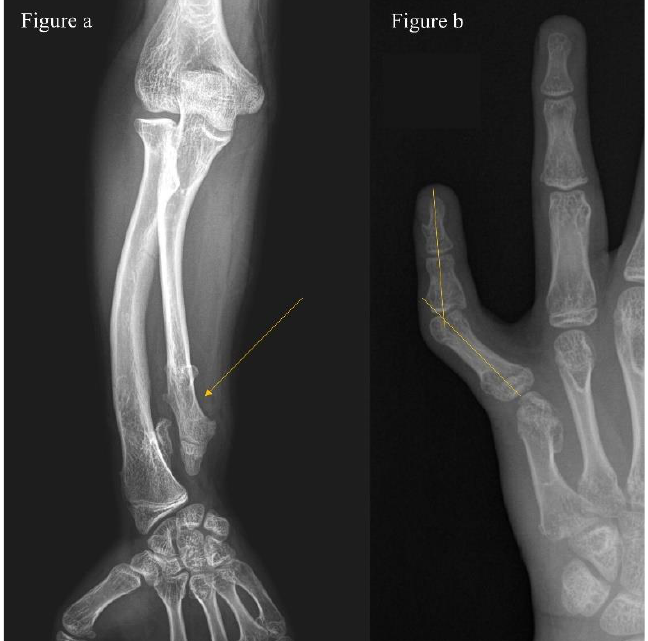
Figure 1. ( a ) A 12-year-old boy with multiple hereditary exostoses shows ulnar shortening and ( b ) radial angulation of the 5th finger due to an abnormal proximal phalanx. Patients were also evaluated for the number of exostoses, with individuals divided into three groups: those with fewer than 10 sites, those with 10 to 20 sites, and those with more than 20 sites. LLD was determined using full-length, standing, and anteroposterior hip-to-ankle radiographs. Leg length was measured from the center of the femoral head